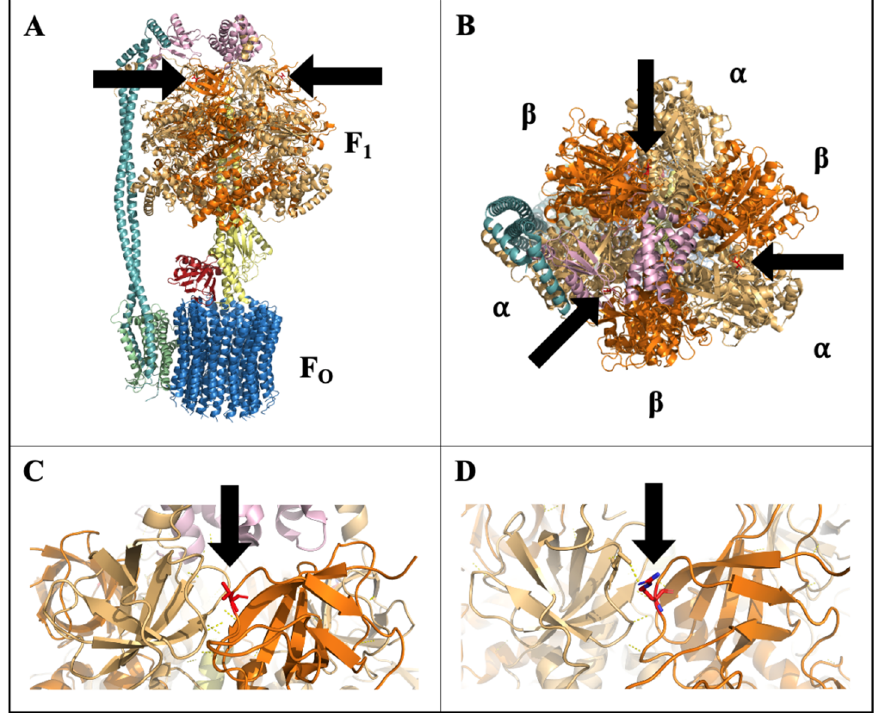
Figure 8. Modeled structure of chloroplast F 1 F O -ATP synthase (CF 1 F O -ATPase) with stick-structure of the amino acid at residue position 86 of the CF 1 β -subunit ( β Thr 86 ) shown, colored in red, and denoted by arrows: ( A ) side-view of full CF 1 F O -ATPase structure, ( B ) top-view showing β Thr 86 at the αβ interface, ( C ) close-up of wild-type β Thr 86 at αβ interface, and ( D ) close-up of ‘Chipper’ amino acid change to β Arg 86 at αβ interface.